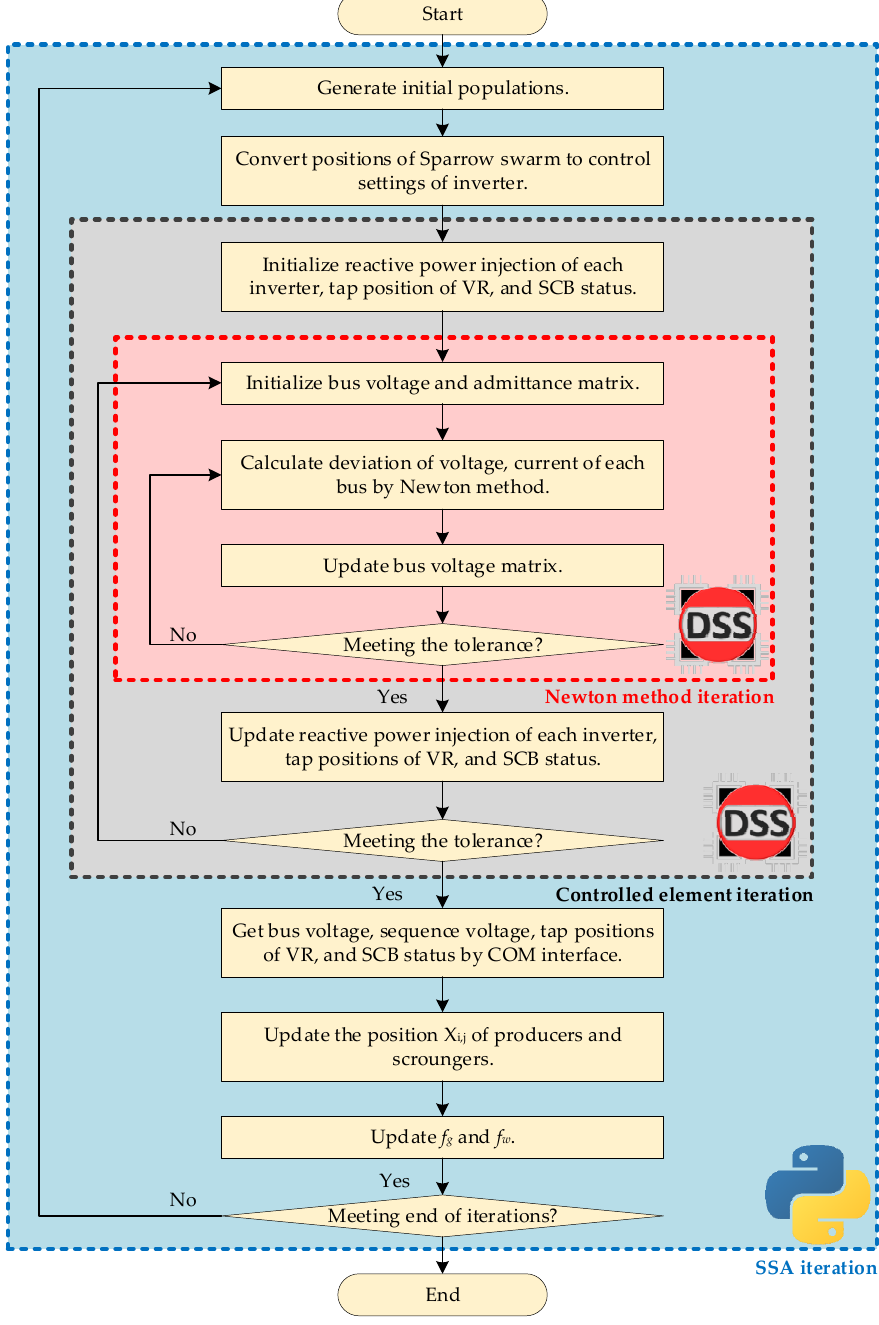
Figure 7. Flow chart of the optimization solution framework.